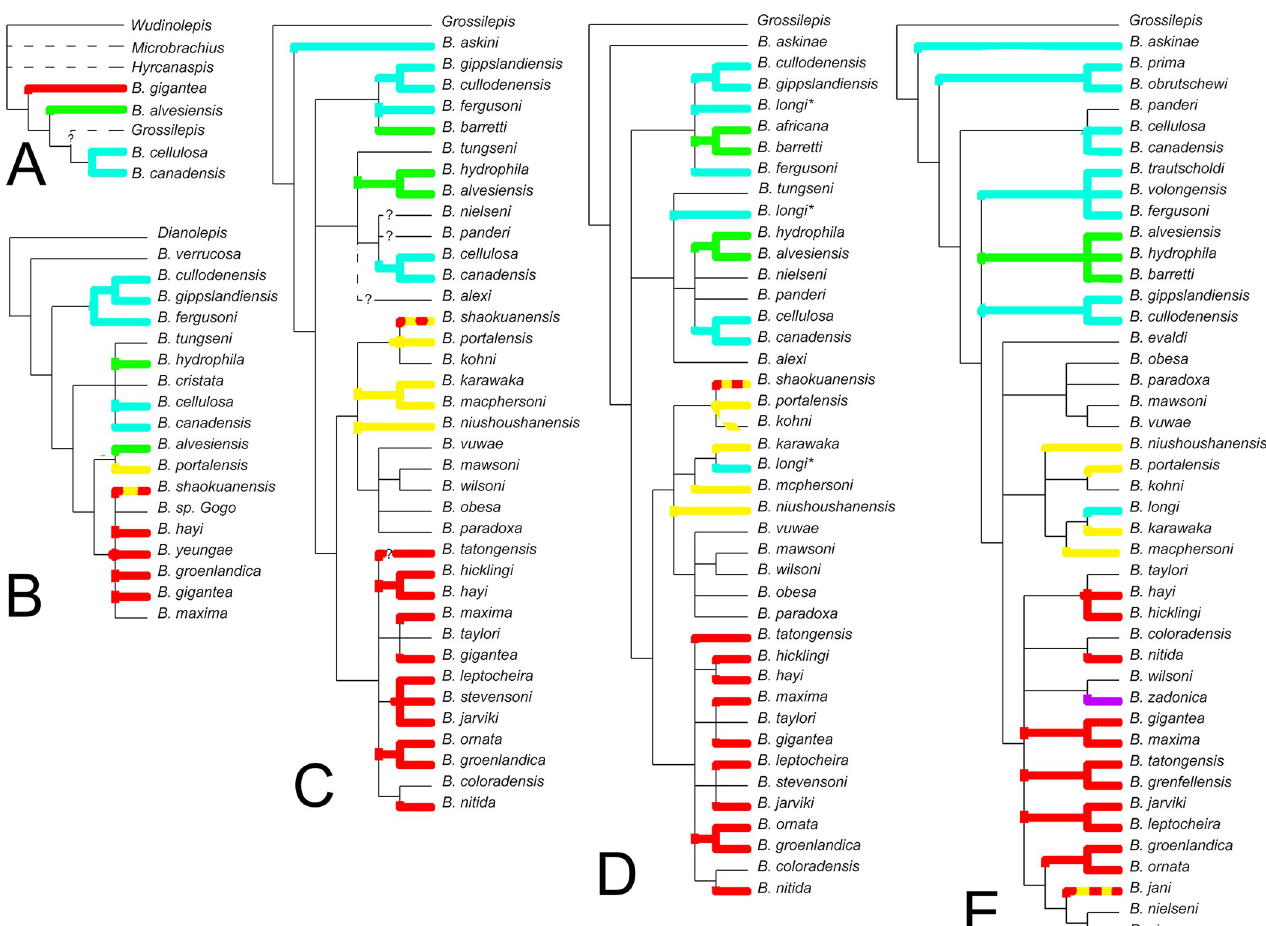
Fig 12. Historical overview of the relationships within the genus Bothriolepis according to: A. Janvier and Pan ([24]:fig. 12); B. Long ([19]:text-fig. 13); C. Young ([25]:text-fig. 68B); D. Johanson and Young ([26]:fig. 10); and E. Luksˇevi č s ([10]:fig. 83). Colours indicate the shape of the preorbital recess for species in which it is known (see Fig